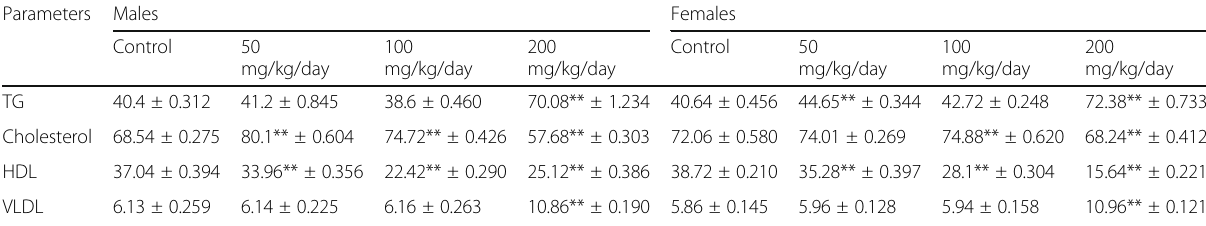
Table 6 Effect of different test doses of product on TG, Cholesterol, HDL and VLDL in male and female rats Parameters Males